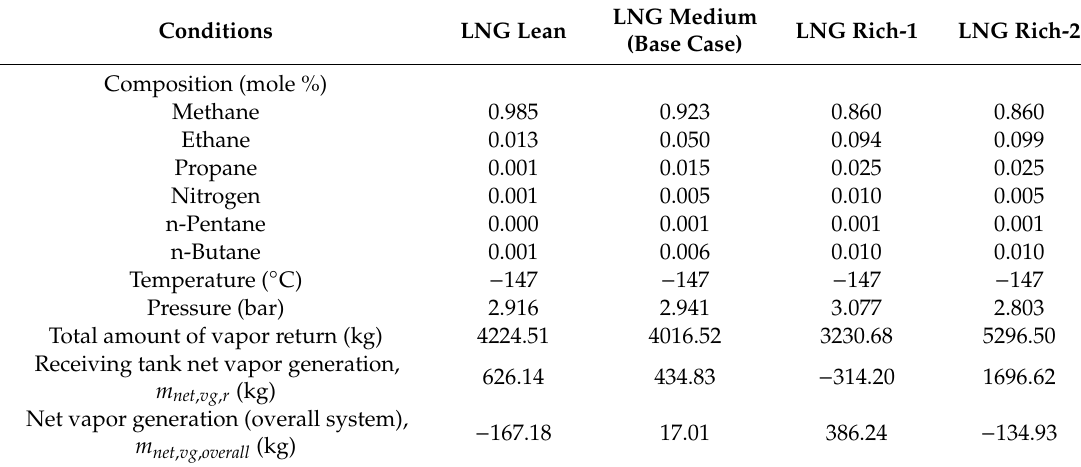
Table 8. Composition of LNG in bunker tanks and